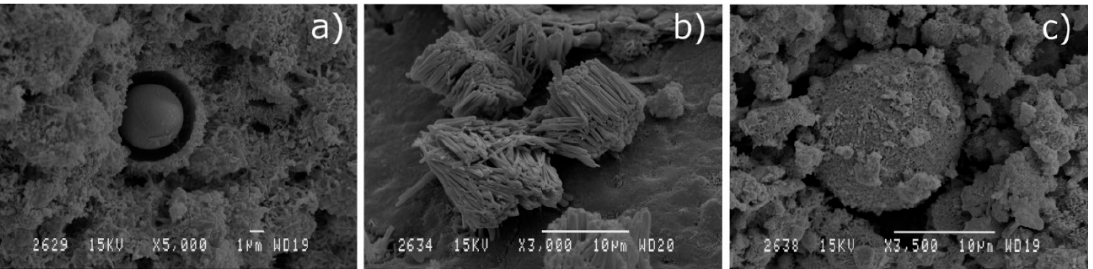
Figure 7. SEM micrographs of concrete samples ( a ) 21- SSA / FA , ( b ) 22- SSA / MD and ( c ) 23- MD / FA , cured for 90 days.